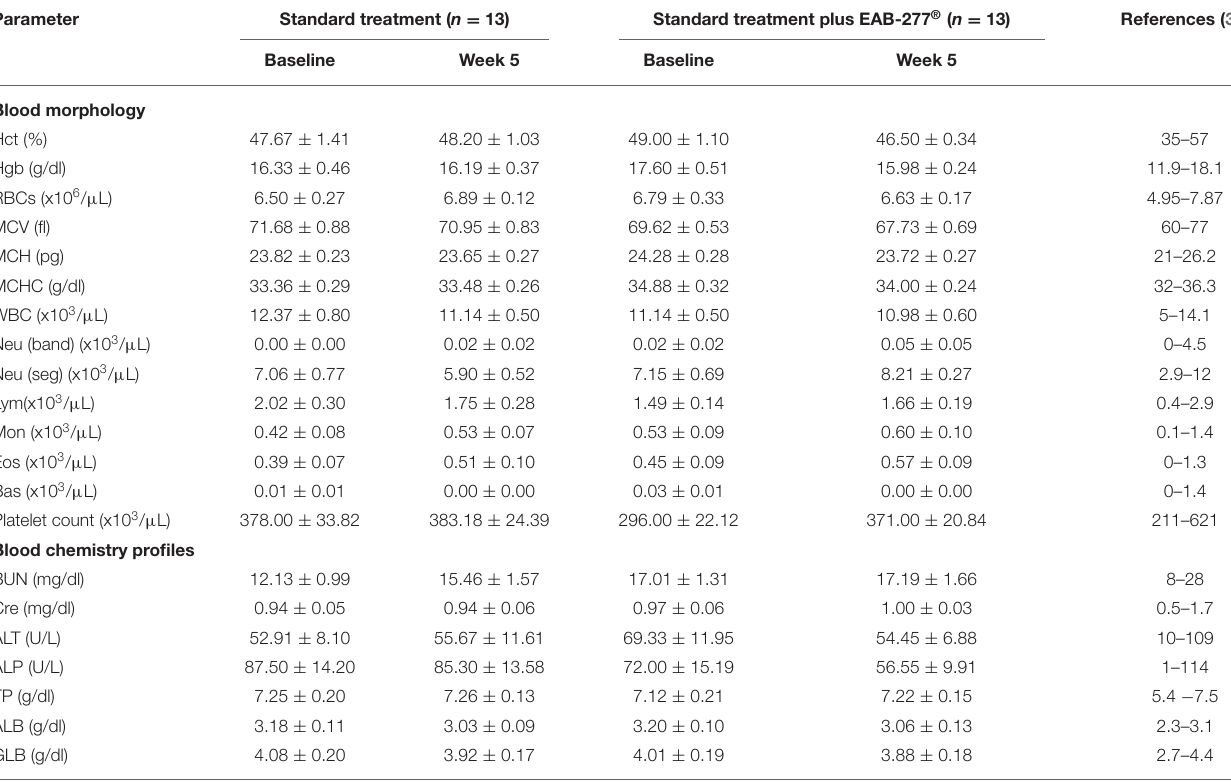
TABLE 3 | Effect of standard treatment and EAB-277 ® on blood morphology and blood chemistry profile in tracheal collapse